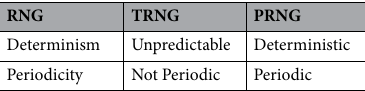
Table 1. TRNG versus